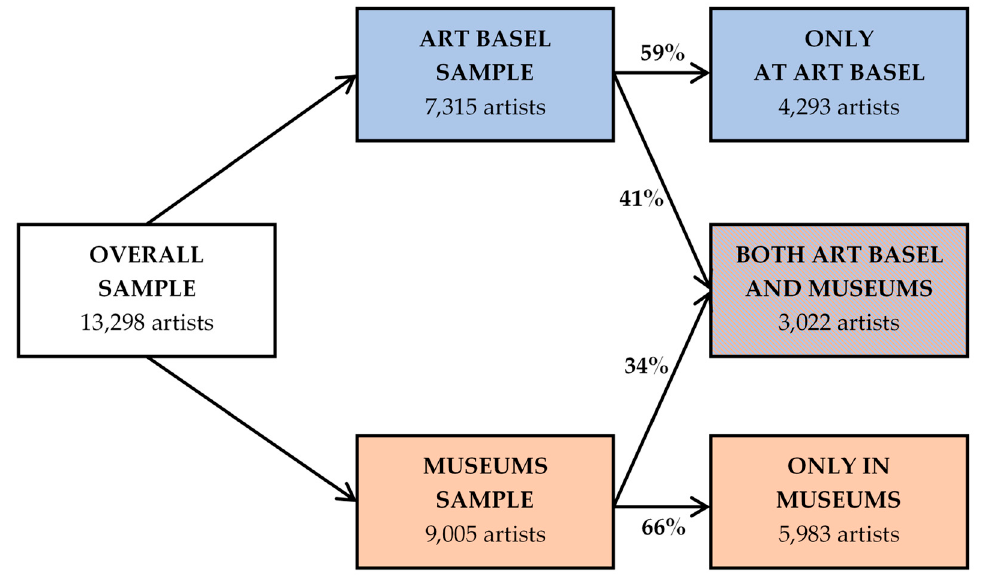
Figure 3. Overall sample structure.